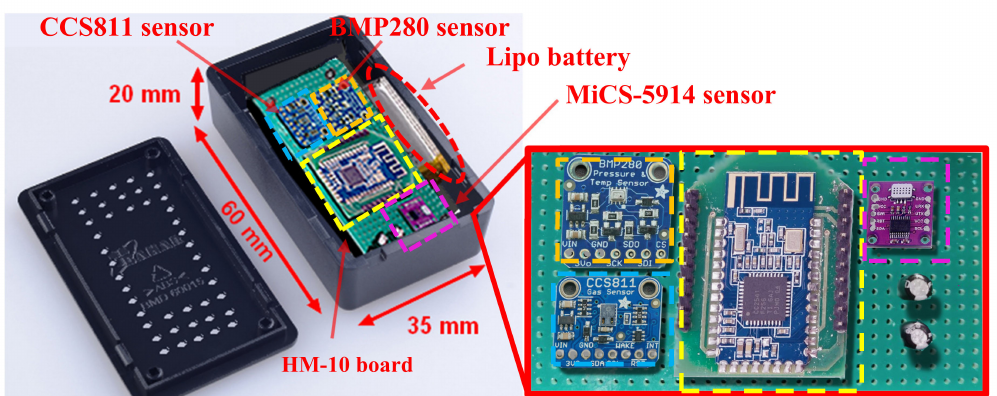
Figure 15. The prototype of the developed BLE smart tag placed inside a plastic box with a perforated